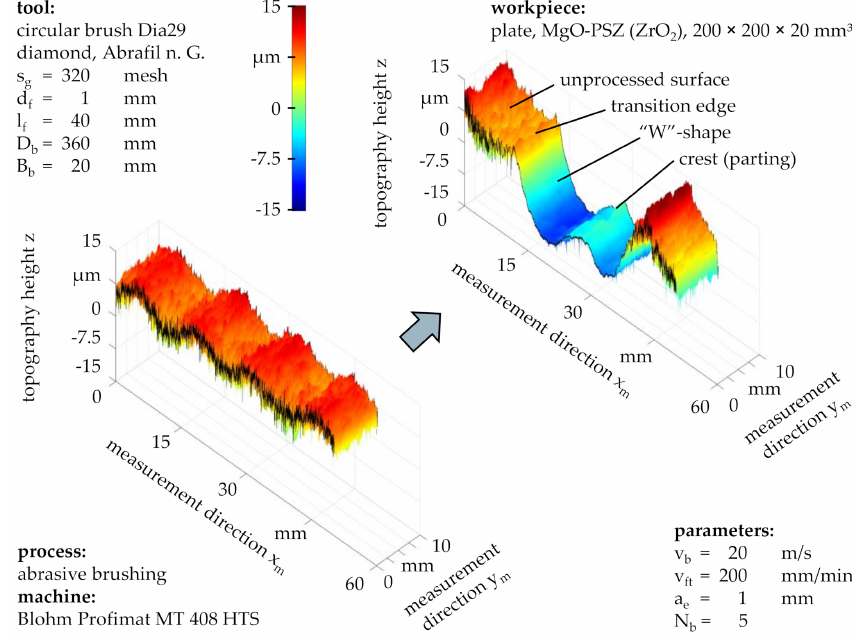
Figure 13. Topography of ZrO 2 , measured across the width of an overbrushed